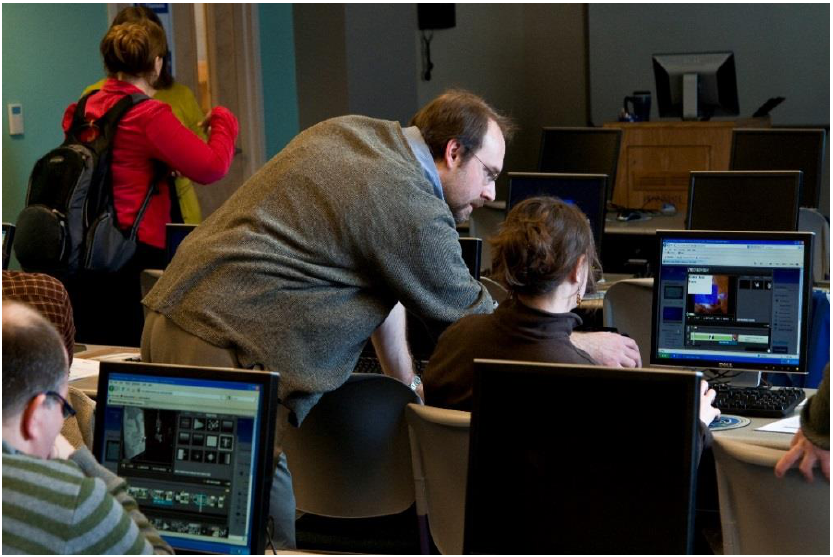
Learning tips and tricks in the Digital